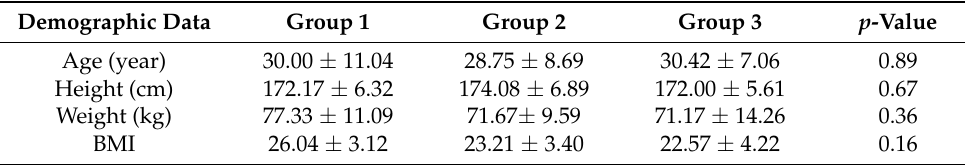
Table 1. Demographic data of subjects in each study